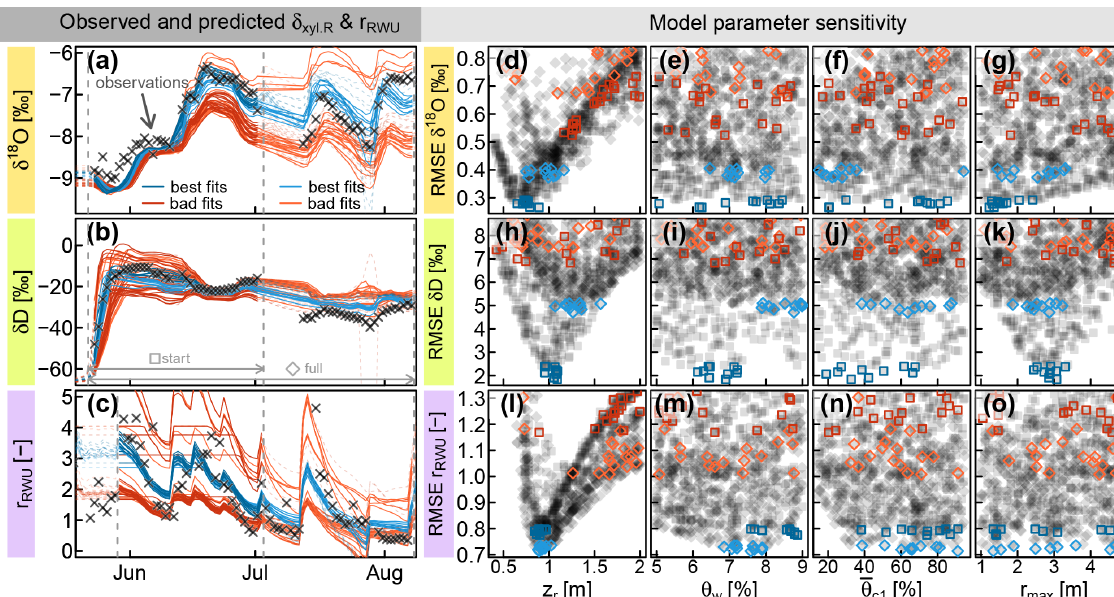
Figure 5. ( a and b ) Observed δ xyl.R ( δ xyl at the stem base, grey crosses) compared to model predictions of δ xyl.R (lines), evaluated over the whole observational record (light blue and orange) or just the start phase (dark blue and red). (c) Root water uptake ratio r RWU derived from soil moisture measurements (grey crosses) and RWU simulations (colored lines). (d–o) RMSE values between observed signatures and simulated signatures in relation to the model parameters z r (rooting depth), θ w (wilting point soil moisture) θ c1 (critical normalized soil moisture of water stress onset) and r max (maximum lateral root extent). The parameter combinations leading to the selected colored time series in (a–c) are colored identically in the respective (d–o) .